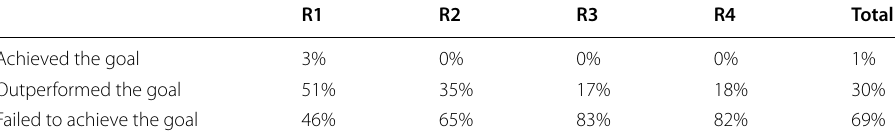
Table 10 Comparison of the follow-up system assessment and target goal